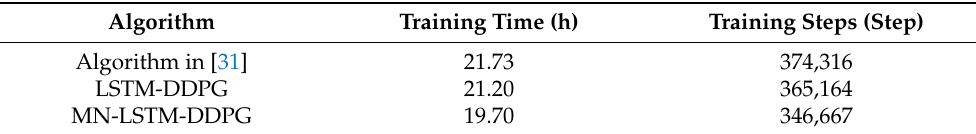
Table 4. Comparison of training time and steps of the improved algorithm in simulation Figure 6b. 6b.